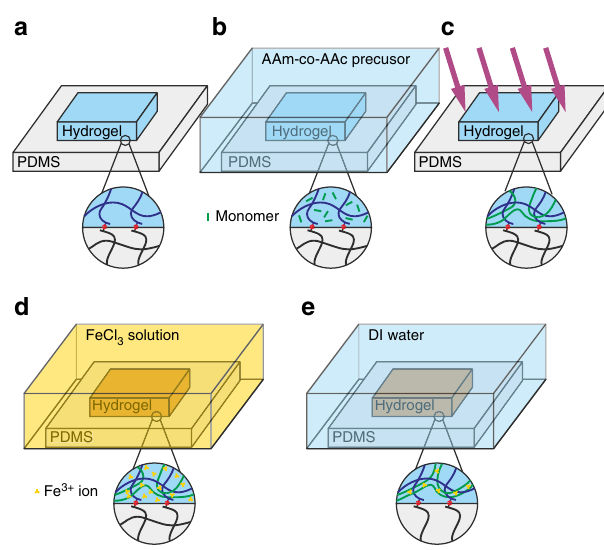
Fig. 3 Toughening the silane modi fi ed PAAm-PDMS by infusing a dissipative interpenetrating network. a A silane-modi fi ed PDMS precursor is spin-coated on a glass slide. A silane-modi fi ed PAAm hydrogel is bonded on the silane-modi fi ed PDMS. b The bilayer is immersed in the precursor of the PAAm-co-PAAc hydrogel for 1 day. c The precursor polymerizes under UV lamp, but does not crosslink at this stage. d The sample is immersed in FeCl 3 solution for 1 day. The Fe 3 + ions form coordinate compounds with the carboxylic acid groups, which physically crosslinks the PAAm-co-PAAc network. The siloxane bonds between the PAAm and PDMS chains are strong bonds, and the coordination complexes are weak bonds. The hydrogel becomes brownish after the crosslinking. e The sample is then immersed in distilled water for 1 day to remove excess Fe 3 + ions